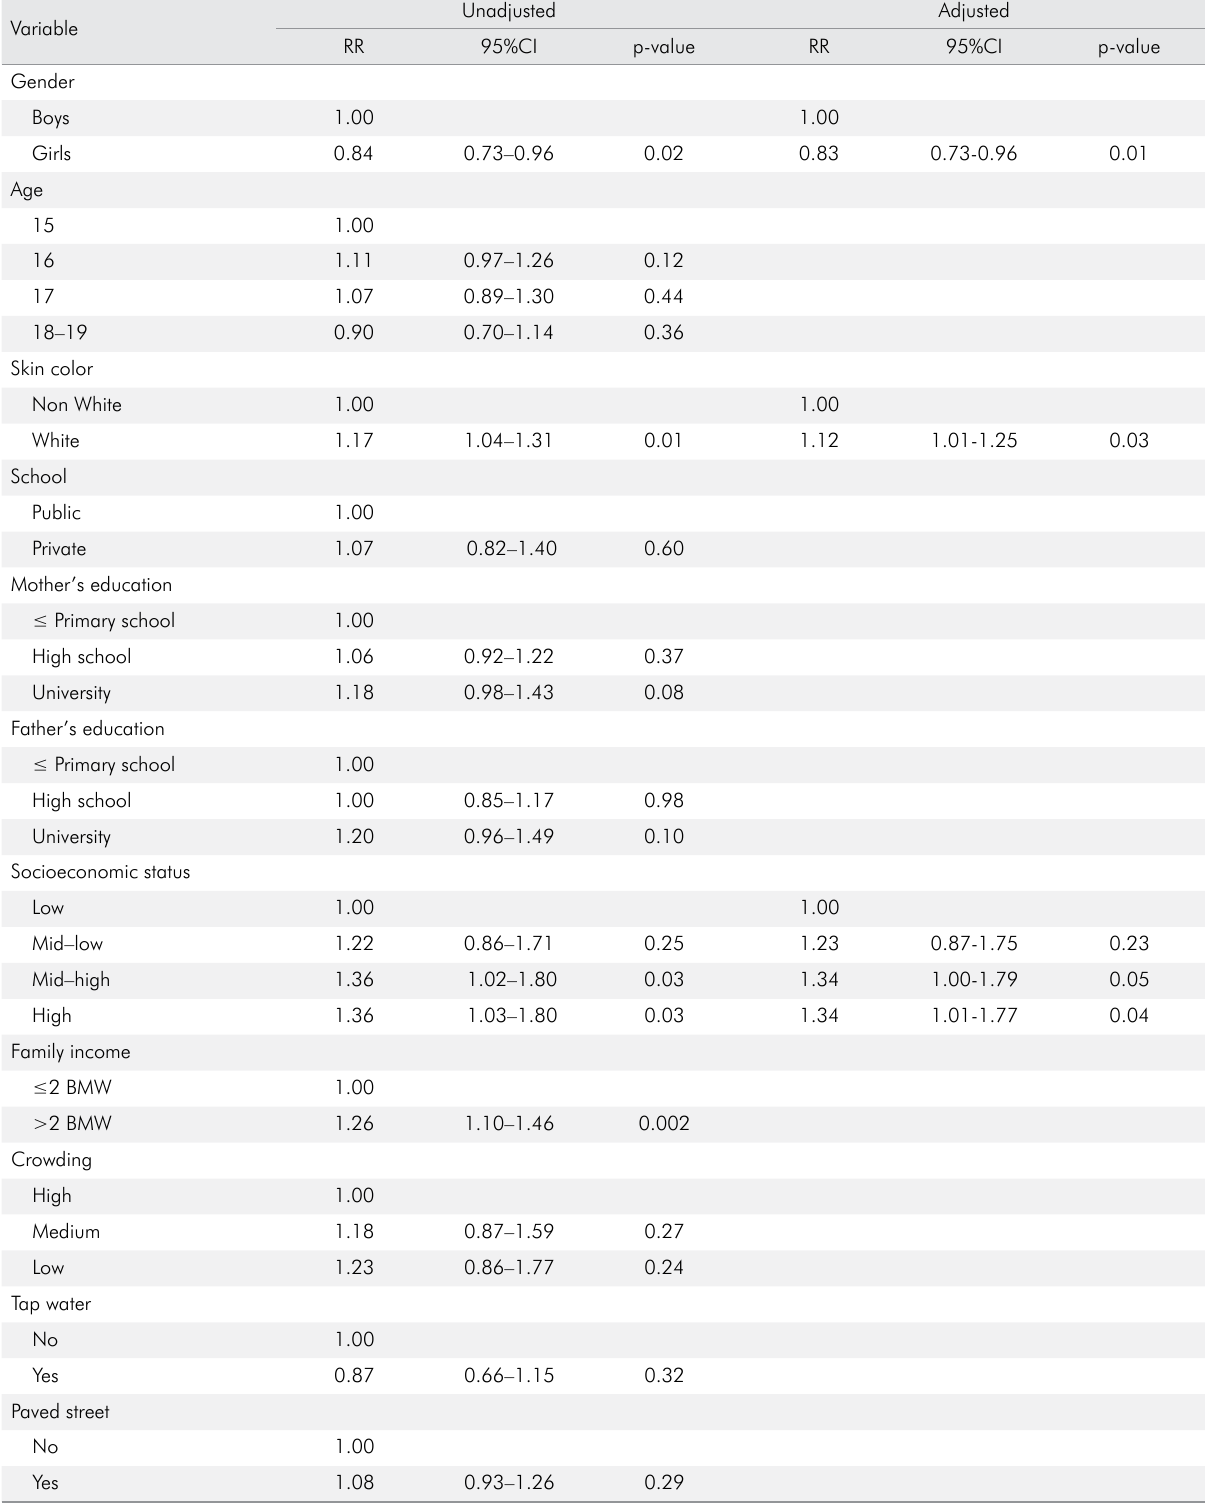
Table 3. Association between explanatory variables and extent of ETW (mean number of affected surfaces). Unadjusted and adjusted Poisson regression analyses. Santa Maria, Brazil, 2018 (n =